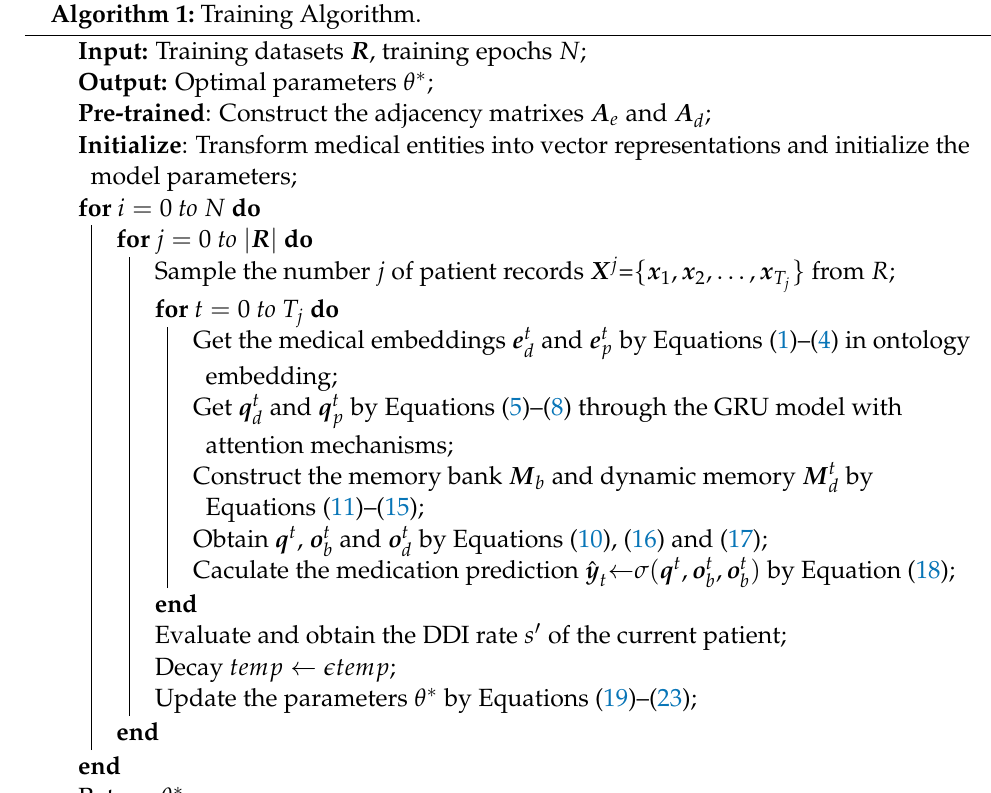
Algorithm 1: Training